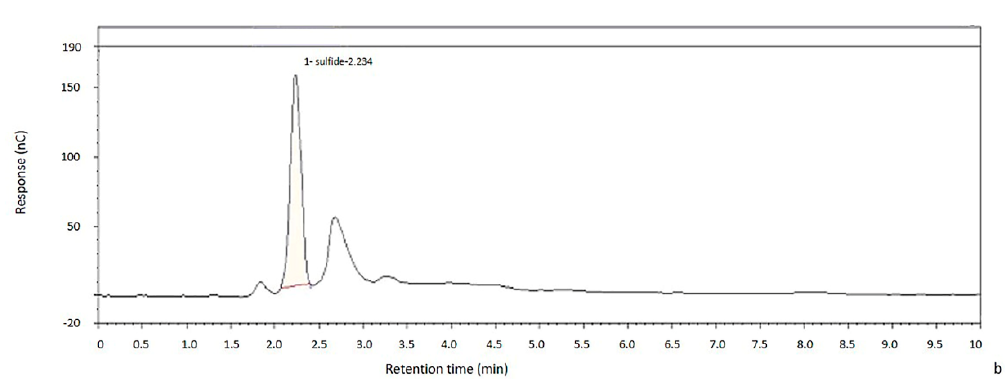
Figure 1. Chromatogram of both a standard ( a ) and a representative cerebrospinal fluid (CSF) ( b ), respectively, have been shown. The sample preparation described does not give any chromatographic interference with sulfide determination. Comparing both chromatograms, sulfide signal shows the exact retention time.